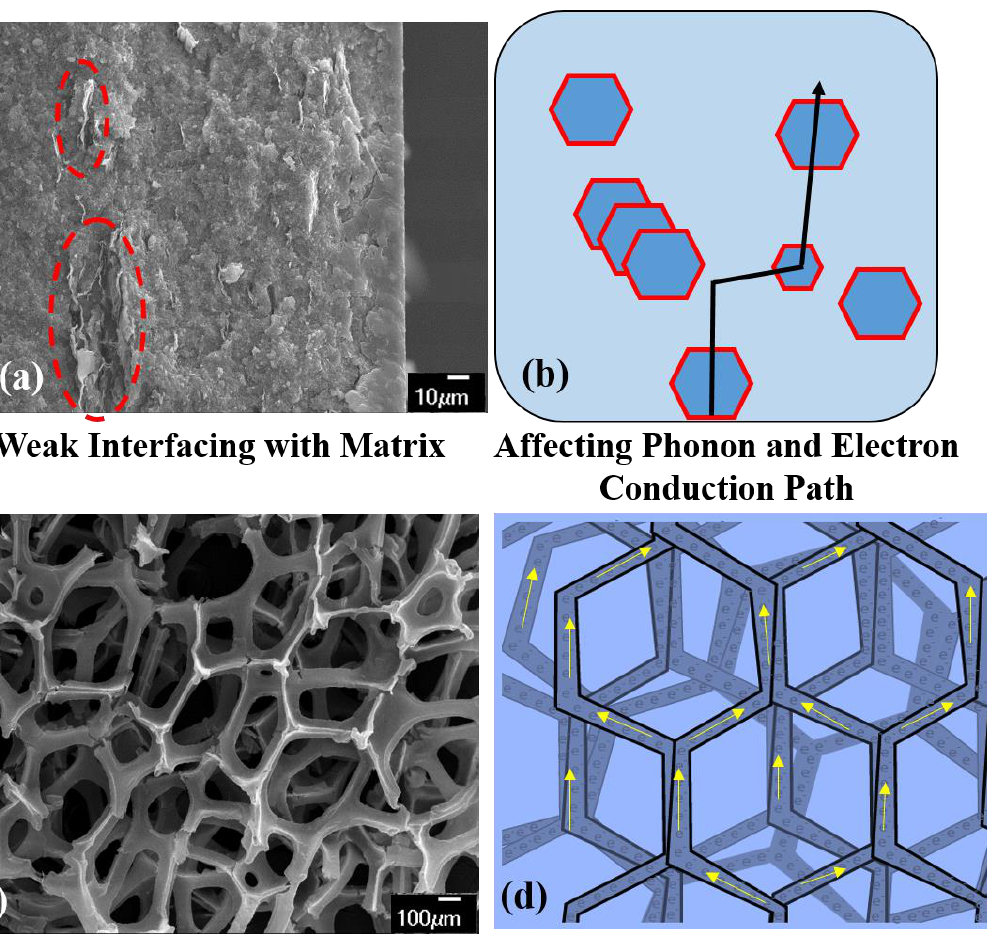
Figure 3. ( a ) SEM image showing clustered and poorly dispersed 2D Gr flakes (highlighted in red dashed oval) in a ceramic matrix; ( b ) schematic representing the discontinuous contact between poorly dispersed 2D Gr in the material matrix, impeding phonon and electron conduction; ( c ) SEM image of pristine GrF; and ( d ) schematic representing how the architecture of GrF offers a seamless pathway for phonon and electron conduction .